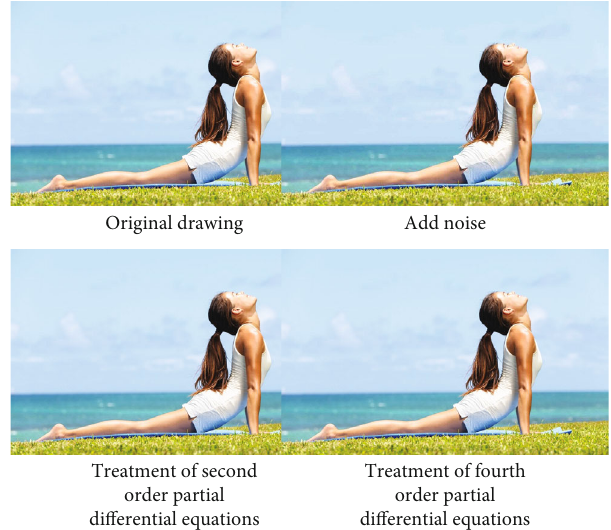
Figure 9: Comparison of image processing e ff ects between second- order partial di ff erential equation and fourth-order partial di ff erential